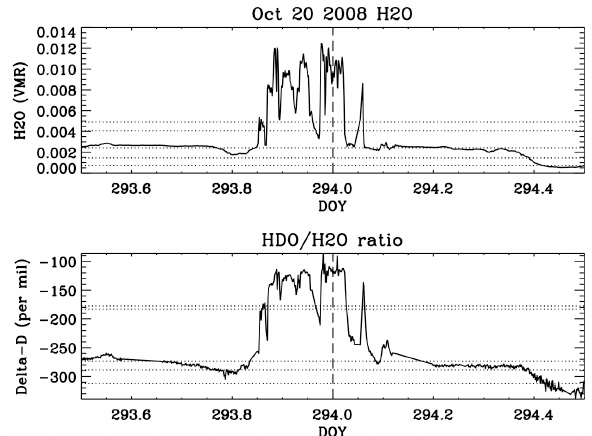
Fig. 6. H 2 O (top) and δ -D (bottom) values derived from averaging Fig. 5. The averaging kernels (rows of the averaging kernel matrix) Figure 5: The averaging kernels (rows of the averaging kernel matrix) for the H 2 O and the LGR and Picarro measurements. The horizontal dotted lines for the H 2 O and HDO components of the retrieval. The cloud top HDO components of the retrieval. The cloud top height is shown as a solid line (with correspond to water values at the first five pressure levels of the TES height is shown as a solid line (with cloud optical depth of 1.3) in cloud optical depth of 1.3) in the right panel. H 2 O profile shown in Fig. 3. The vertical dashed line corresponds the right panel. Figure 6: H 2 O (top) and δ -D (bottom) values derived from averaging the LGR and Picarro measurements. The horizontal dotted lines correspond to water values at the first to the time of the TES five pressure levels of the TES H 2 O profile shown in Figure 3. The vertical dashed line corresponds to the time of the TES overpass.